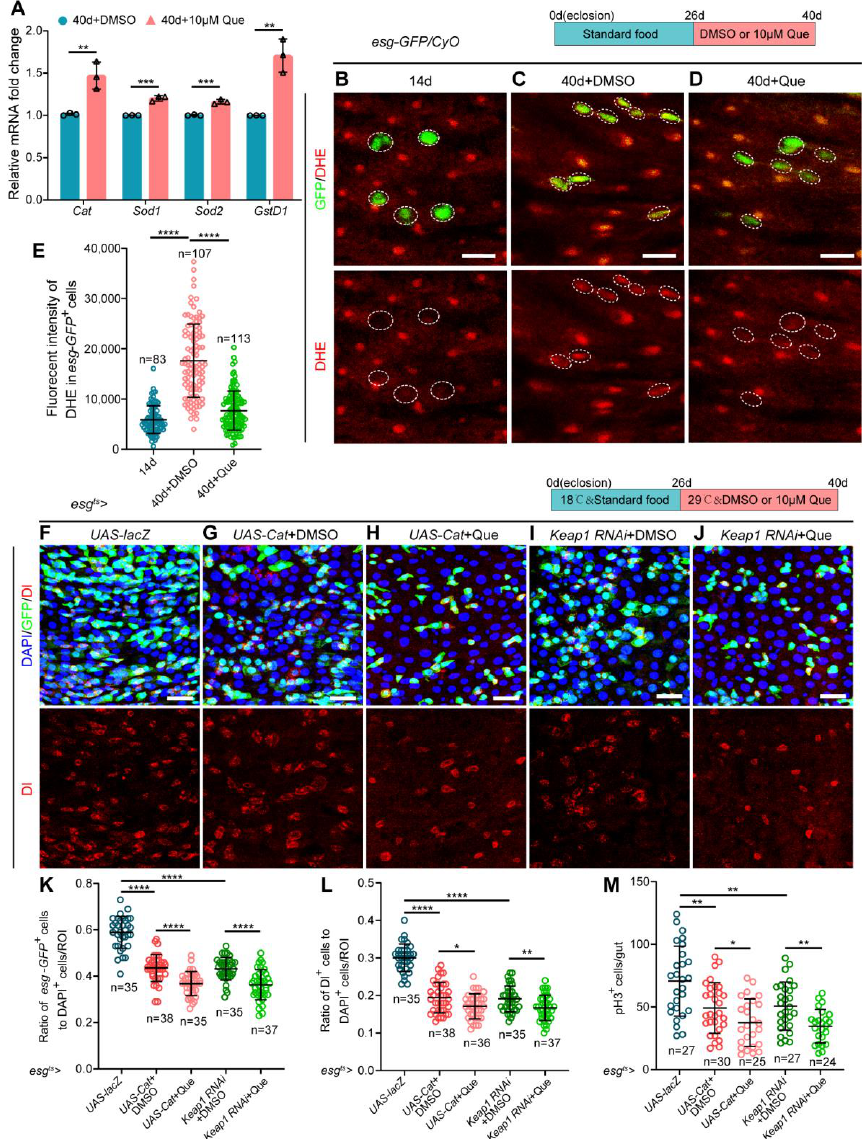
Figure 4. Que prevents age-related hyperproliferation of ISC partially through its antioxidative ability. ( A ) RT-qPCR analysis of the antioxidant-related genes ( Cat , Sod1 , Sod2 , and GstD1 ) in the midguts of 40-day-old flies fed with or without Que. Three independent experiments were conducted. ( B – D ) Representative immunofluorescence images of the posterior midguts of 14- ( B ) and 40-day-old ( C ) flies without Que supplementation and 40-day-old flies with 10 µ M Que supplementation ( D ) stained with DHE (red; ROS maker). Esg-GFP + cells and DHE staining are circled by the white dashed line. The top panels represent the merged images, whereas the bottom panels represent DHE staining. Scale bars represent 10 µ m. ( E ) Quantitation of DHE fluorescence intensity in esg-GFP + cells from experiments ( B – D ). Each dot indicates one esg-GFP + cell. ( F – J ) Representative immunofluorescence images of posterior midguts of flies carrying esg ts -Gal4 -driven UAS-lacZ ( F ), UAS-Cat + DMSO ( G ), UAS-Cat + Que ( H ), Keap1 RNAi + DMSO ( I ), and Keap1 RNAi + Que ( J ) stained with DAPI, GFP, and Dl. The top panels represent the merged images, whereas the bottom panels represent Dl. Scale bars represent 25 µ m. ( K , L ) The ratio of esg-GFP + cells ( K ) and Dl + cells ( L ) to DAPI + cells per ROI in the posterior midguts of flies in experiments ( F – J ). n: number of ROI counted. ( M ) The number of pH3 + cells in the whole gut of flies in experiments ( F – J ). n: number of gut counted. Error bars represent SDs. Student’s t -tests, * p < 0.05, ** p < 0.01, *** p < 0.001, and **** p <